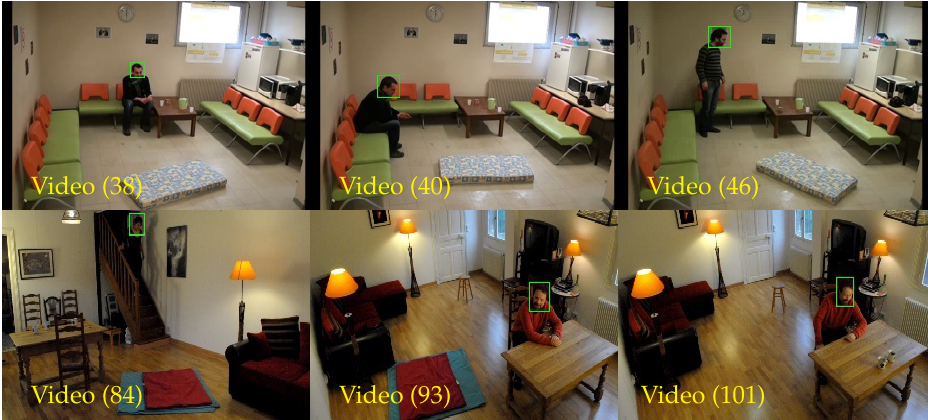
Figure 14. Image samples that showing tracked objects having similar information with the background information.